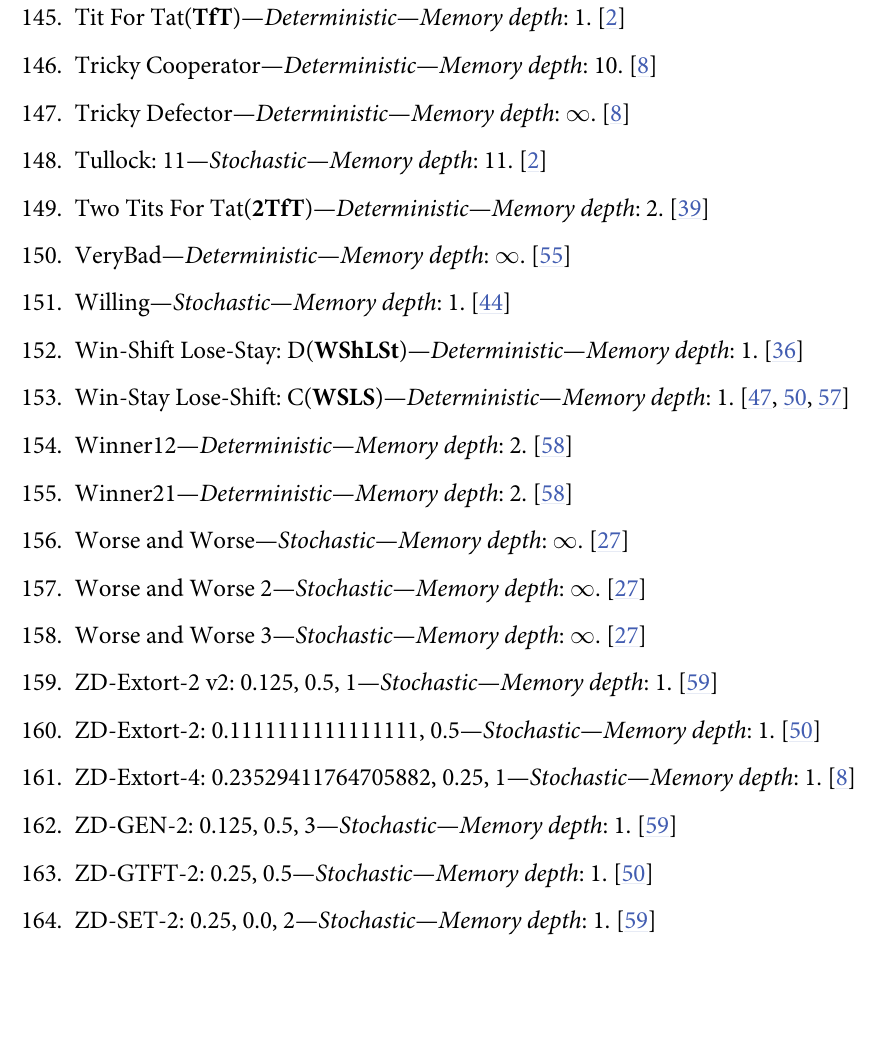
S1 Fig. The fixation probabilities x S2 Fig. The fixation probabilities x